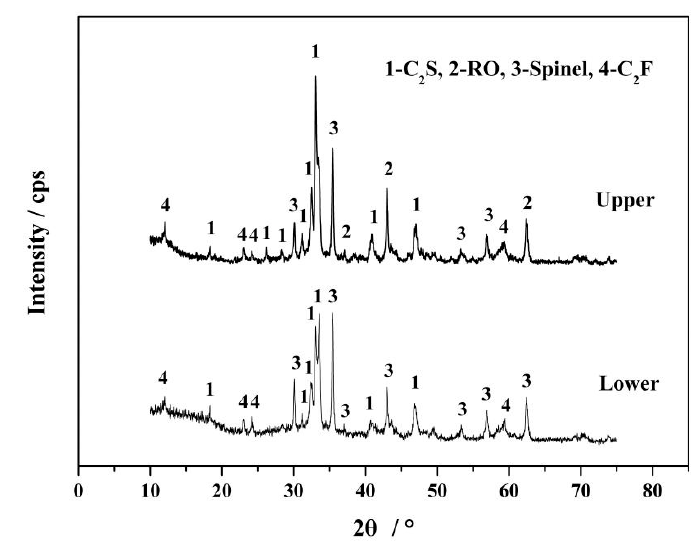
Figure 3. XRD patterns of the upper and lower modified slags held at 1673 K for 240 min on a kilo-scale.